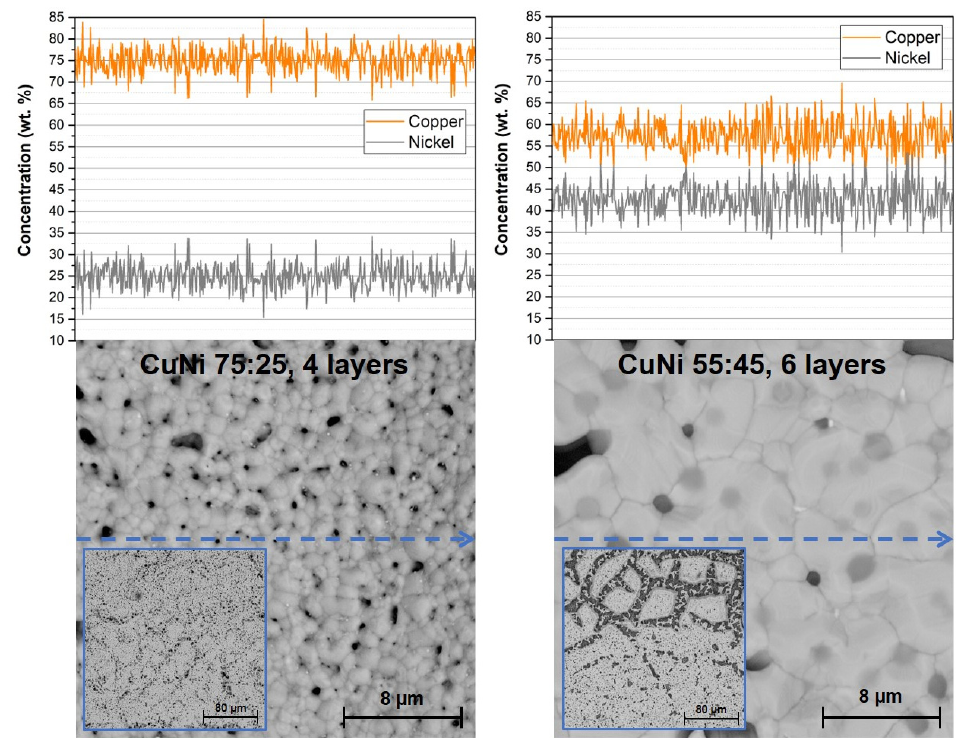
Figure 3. SEM images and EDS analyses of element distribution (line scan) in copper–nickel films.